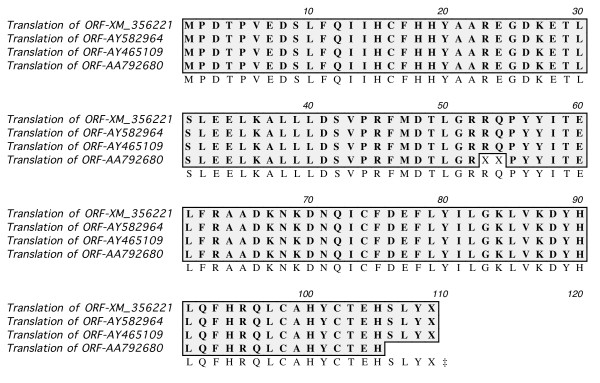
Alignment of the translation products of the predicted ORFs from the various GenBank entries related to mouse S100A7/psoriasin.